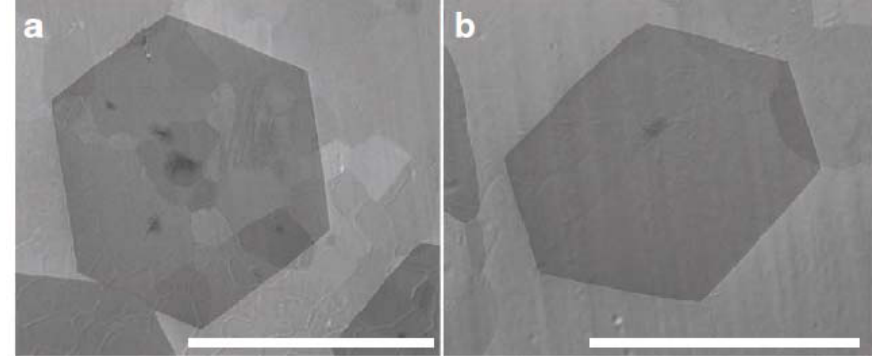
Figure 10. Scanning electron microscope (SEM) images of graphene grains on a Pt foil. The scale bars in are ( a ) 1mm; and ( b ) 0.5 mm respectively. Reprinted with permission from [108]. Copyright (2012) by the Macmillan Publishers